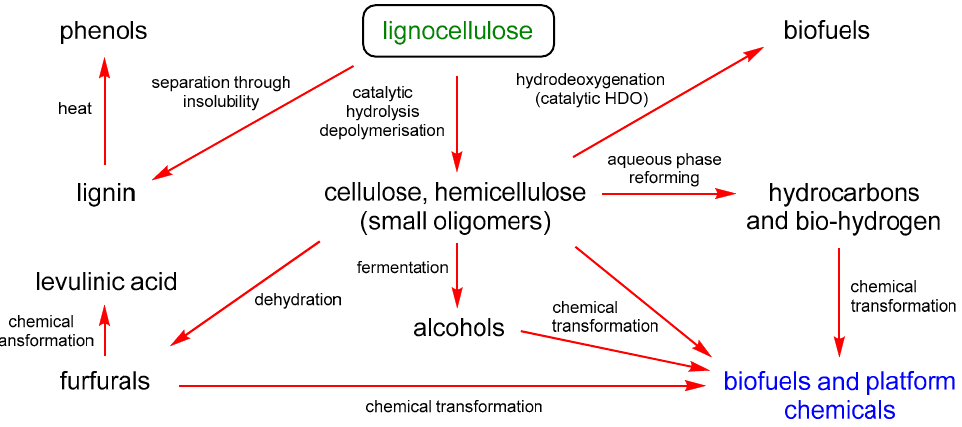
Figure 1. Lignocellulosic pathways. A scheme for a chemo-catalytic biorefinery [25].